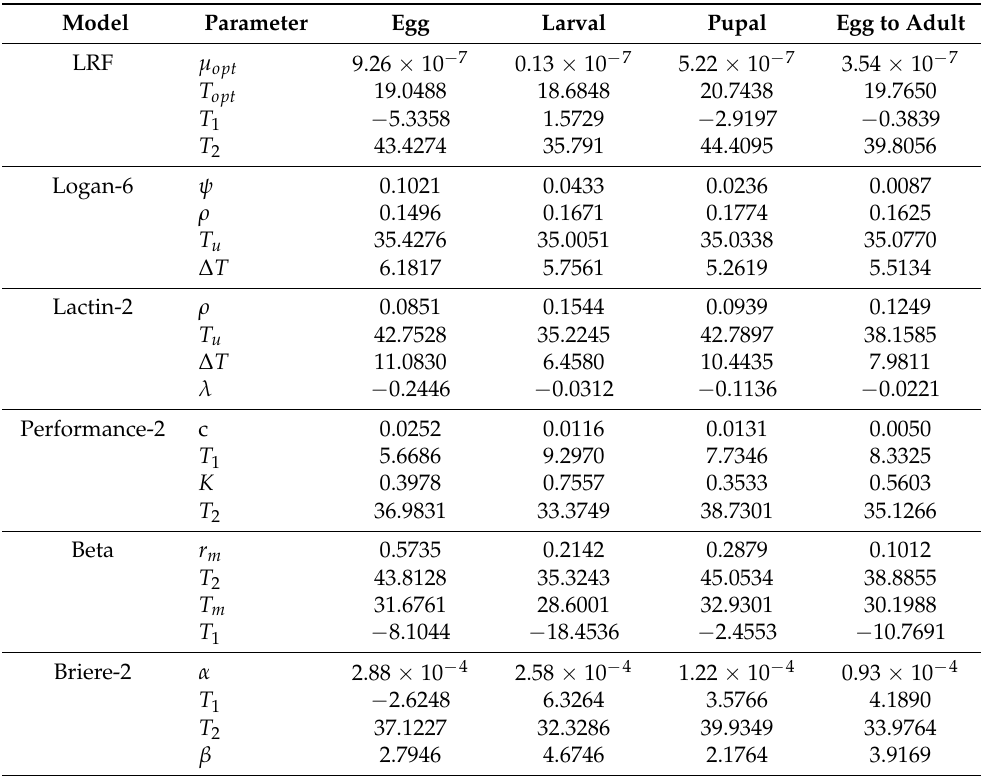
Table 4. Estimated parameter values of the six non-linear models describing the relationship between temperature and development rate of Feltiella acarisuga